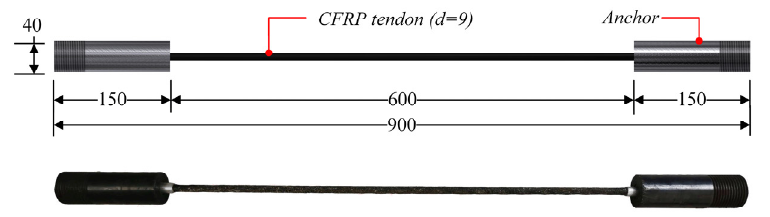
Figure 1. Specimen of tensile test (Unit: mm).